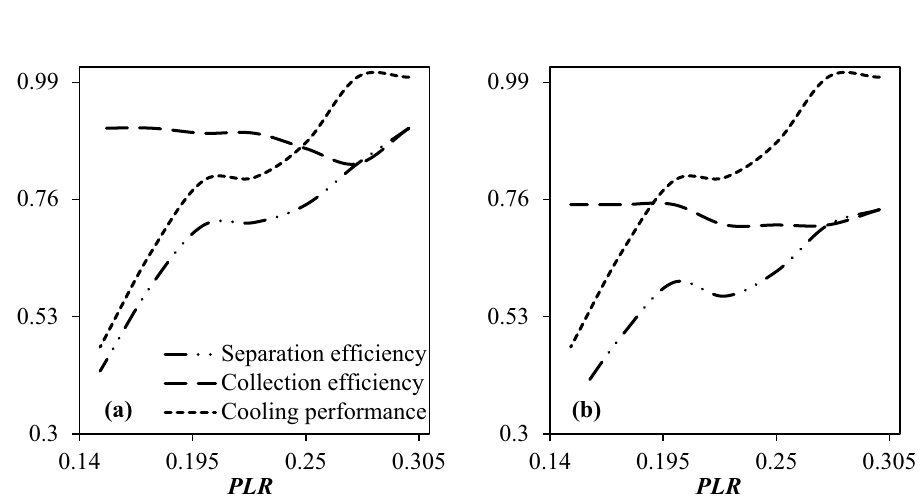
Figure 13. The influence of PLR on the separation efficiency of water ( a ) and condensate ( b )